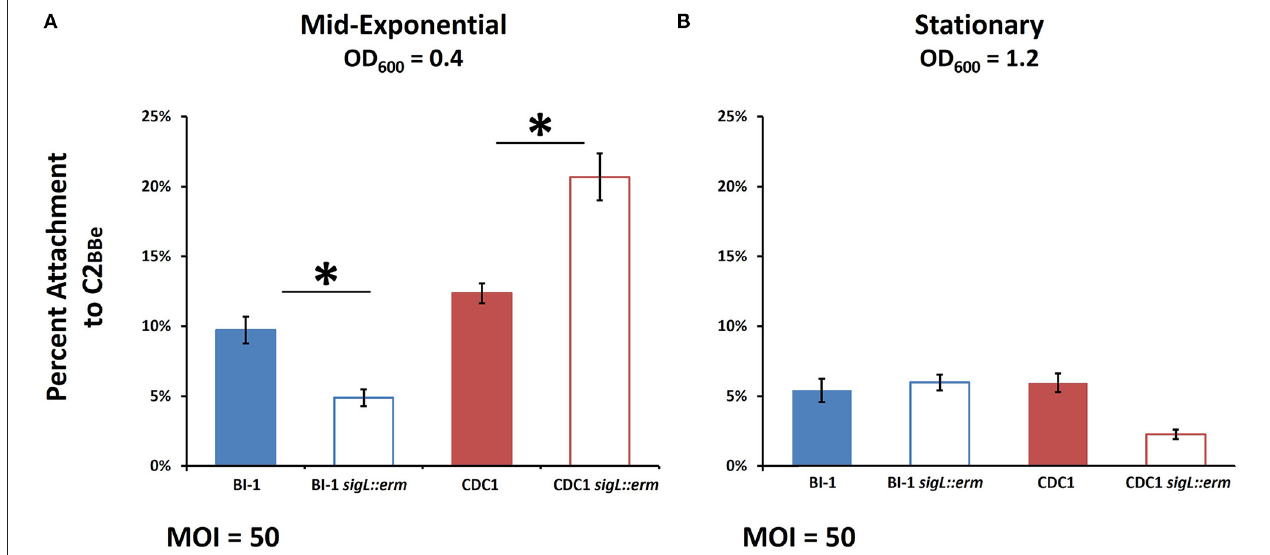
FIGURE 7 | Host cell attachment in sigL::erm is phase- and ribotype-dependent. C. difficile cultures were grown to mid-exponential or stationary phase and added to Caco-2 BBe intestinal epithelial cell monolayers. Percent attachment was calculated by adhered CFUs as a percentage of the initial inoculum CFUs. (A) Attachment to Caco-2 BBe intestinal epithelial cells in mid-exponential phase. (B) Attachment to Caco-2 BBe intestinal epithelial cells in stationary phase. The assays were conducted in biological triplicate and samples were compared using ANOVA and Tukey’s HSD post-hoc test. * p <